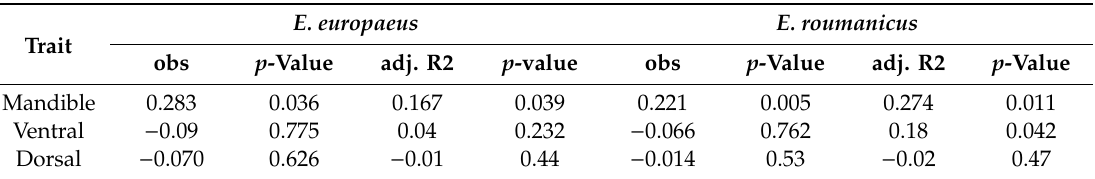
Table 3. Geographic structure of the data. Results of Mantel tests for shape and regression for size for ventral and dorsal sides of the cranium and the